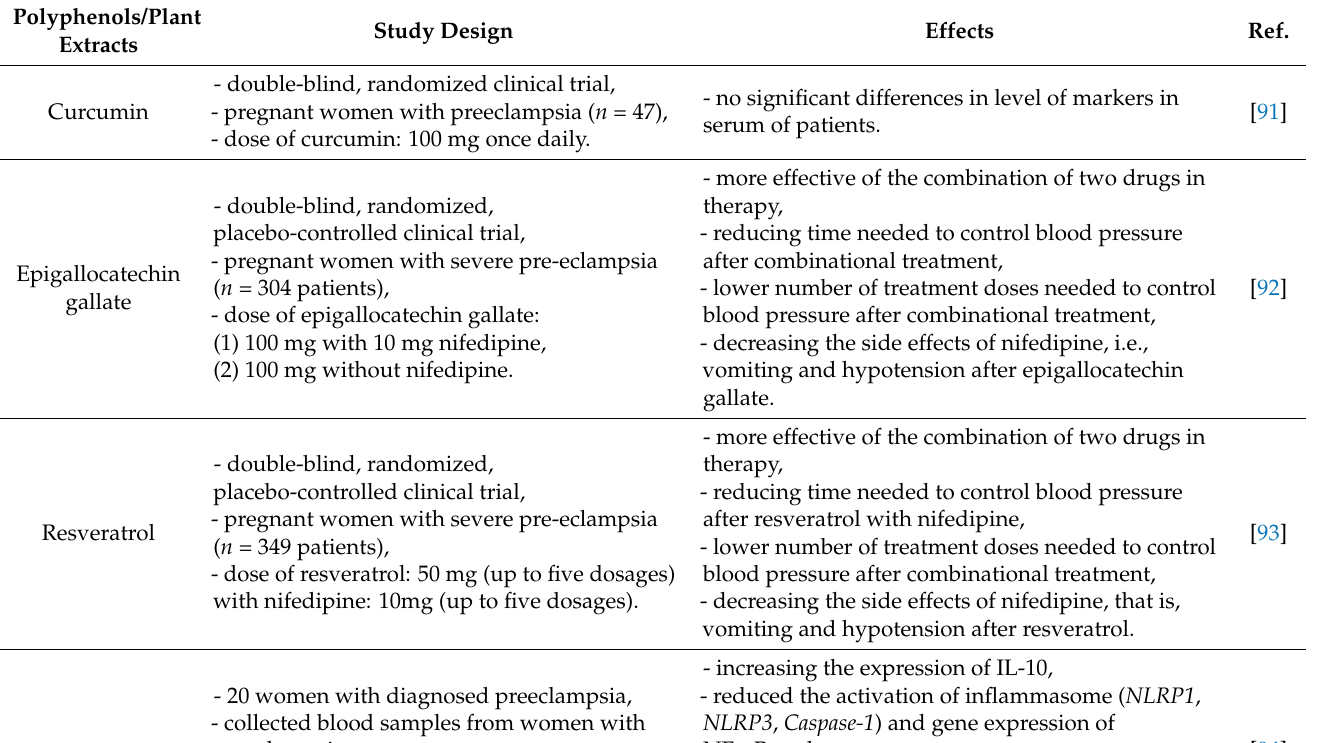
Table 2. Summary of studies on pharmacological effects of plant-derived polyphenols and plant extracts in clinical trials and ex vitro